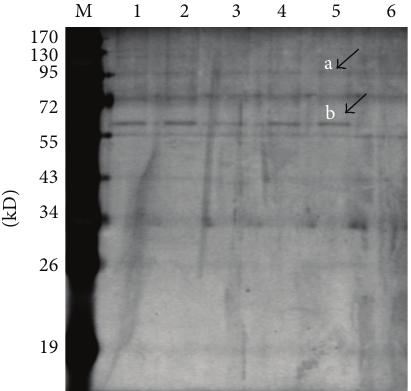
Figure 3: Demonstration of MAb with BLZ211 cells protein reaction by coimmunoprecipitation. M: marker; (a) Hsp74 (b) keratin 1. Lanes 1–5: BLZ211 cells protein; lane 6: negative control; lanes identified by LC-MS/MS.